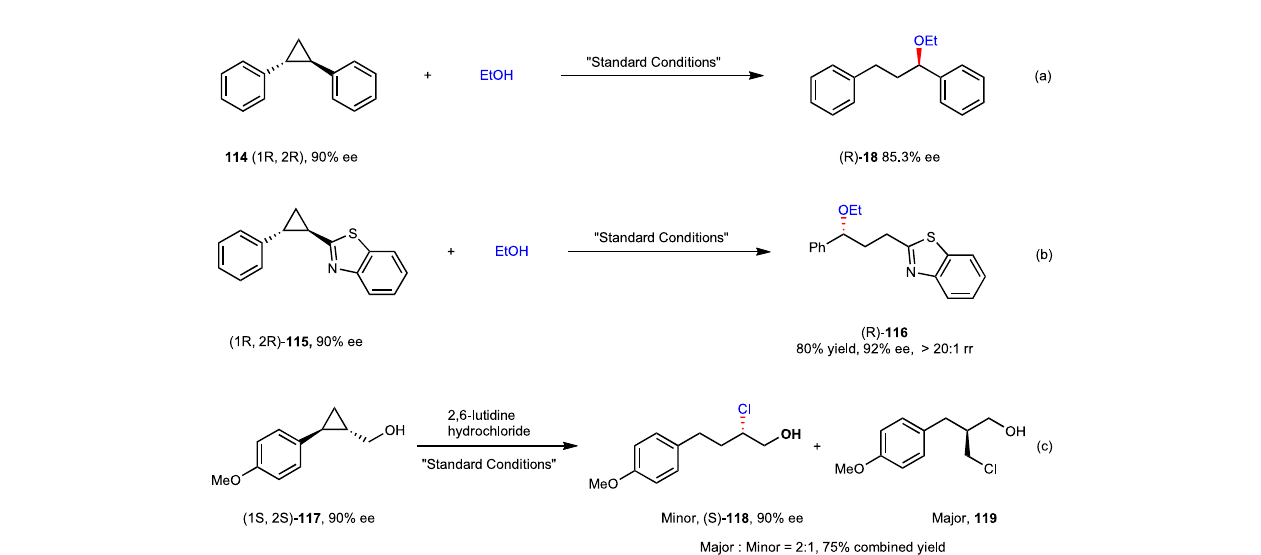
Nature Communications| (2022)